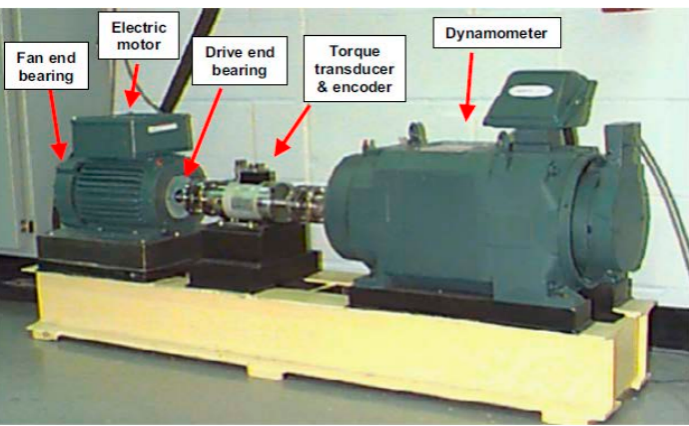
Figure 1. Case Western Reserve University benchmark for recording bearing dataset.